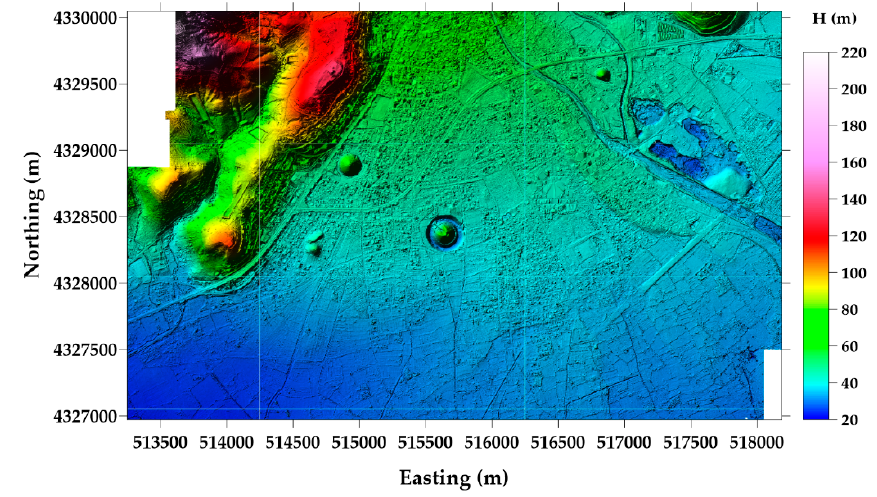
Figure 9. Digital terrain model (DTM) generated using partitioned point clouds and combined using Global Mapper software, artifact of interpolation process along the tile boundaries are recognized.